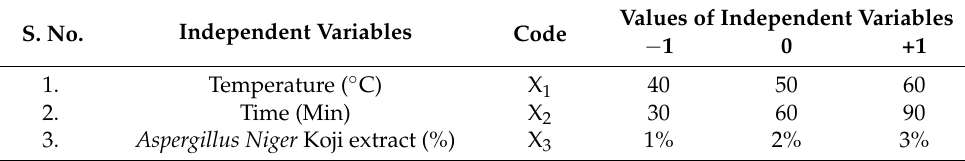
Table 1. Levels of independent parameters for sonication experiment. S.